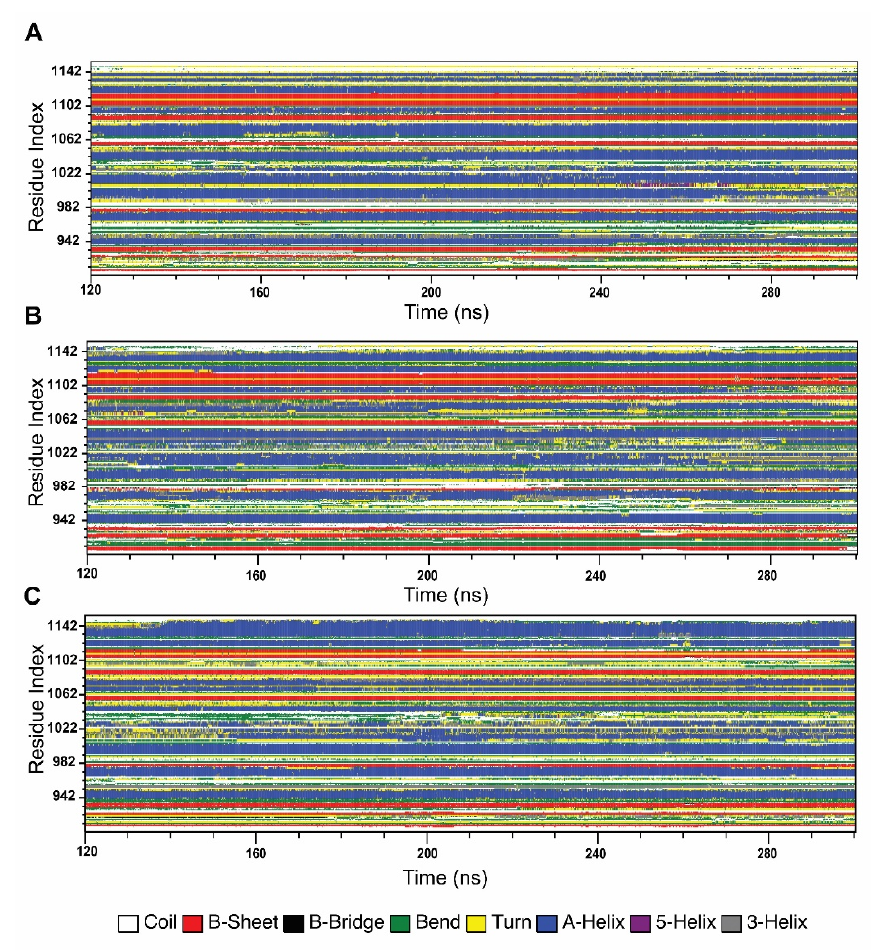
Figure 7. Effect of variants in the stability of the secondary structure elements of the NBD1 domain during the simulation. ( A ) Wild-type, ( B ) G1050V, ( C ) S1067C.